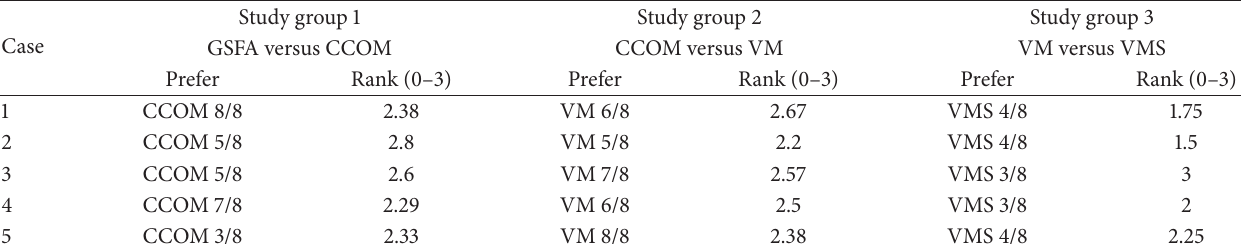
Table 2: Study results—questions 1 and